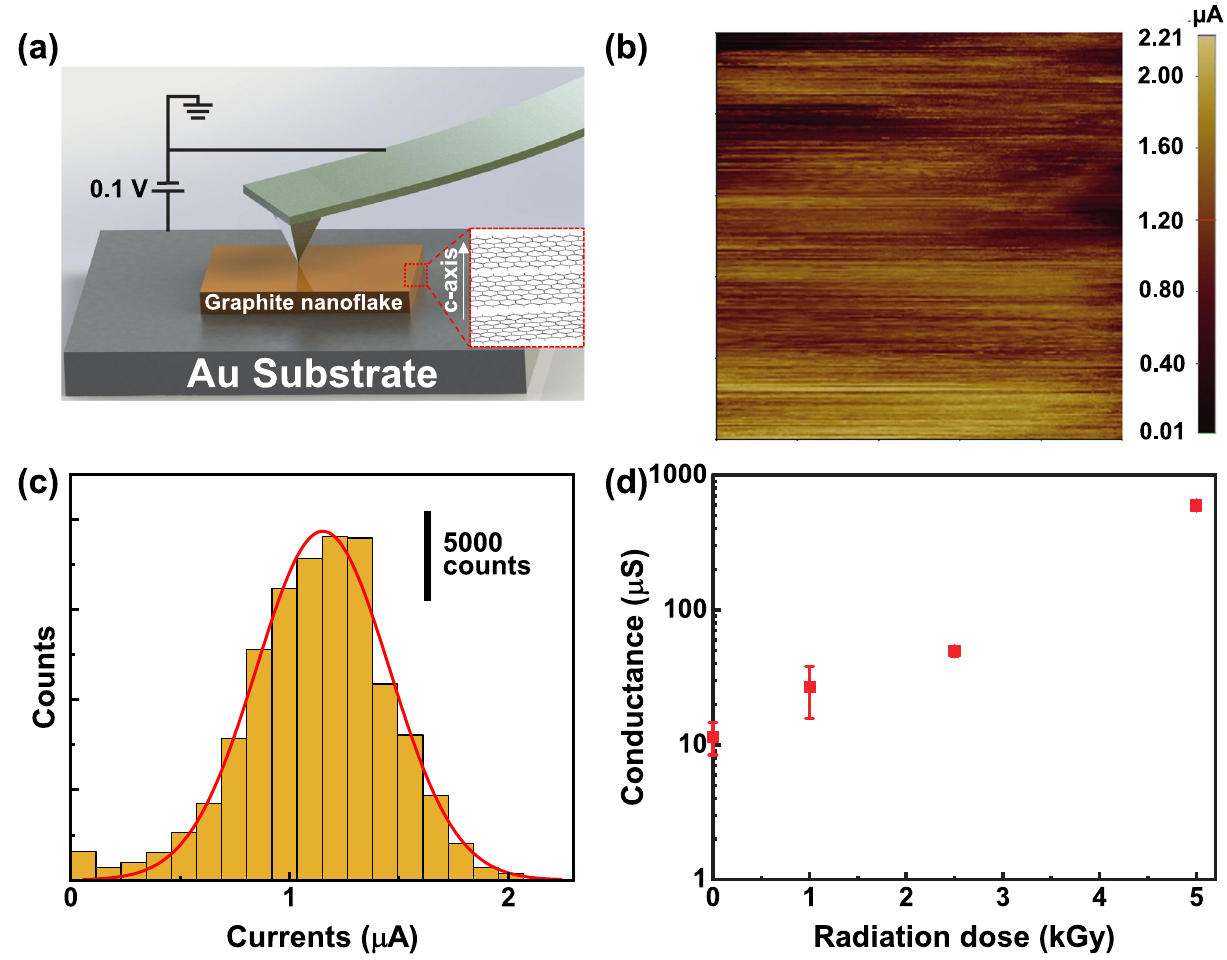
Figure 1. Electrical conductance of GnFs exposed to different gamma-ray radiation doses. ( a ) The schematic of CP-AFM for measuring electrical conductance. The inset in ( a ) shows the schematic of GnFs orientation in the measurement, the basal plane of GnFs parallel to the Au substrate. ( b ) 2D current map of GnF sample with no gamma-ray irradiation (i.e., 0.0 kGy). The scanning size is 250 × 250 nm 2 . ( c ) Current histogram obtained from the 0.0 kGy GnF. The current histogram is constructed from 2D current map [shown in ( b )]. The value of average current is obtained by performing a curve fitting analysis to the current histogram with Gaussian distribution. ( d ) Electrical conductance versus gamma-ray radiation dose. An increase in gamma-ray radiation dose leads to an exponential increase in the electrical conductance of